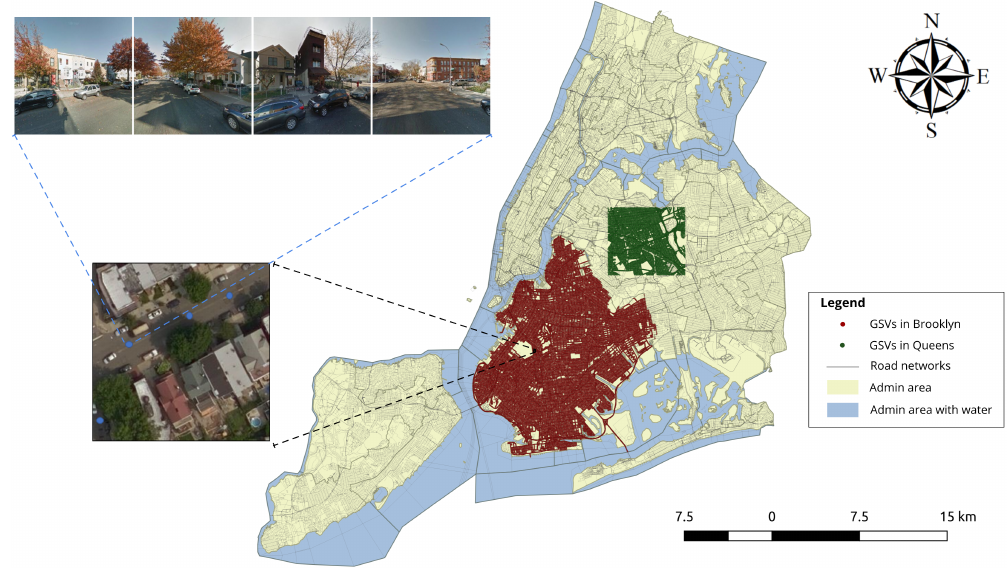
Figure 7. Google street views in the study